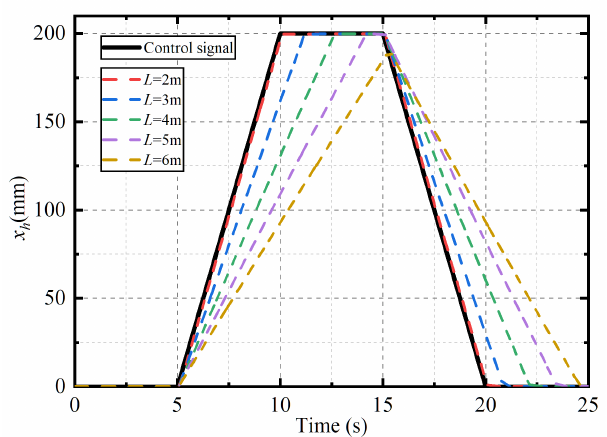
Figure 15. Displacement output, x h , at different length of slender pipiline, L , when depth is 11 km.